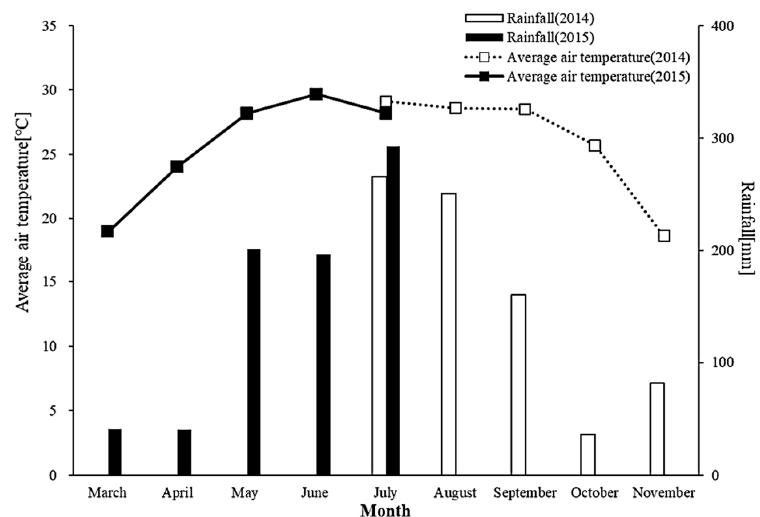
Figure 1. Summary of the average air temperature and rainfall in 2014 and 2015 growing seasons.